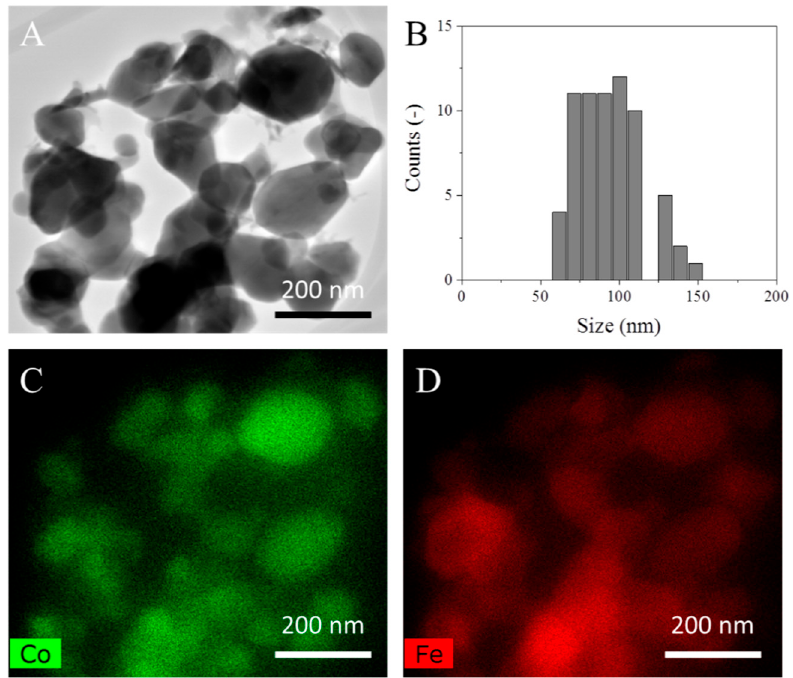
Figure 1. ( A ) Representative transmission electron microscope (TEM) images of the bimetallic catalyst, ( B ) particle size distribution ( C ) Co mapping, ( D ) Fe mapping.